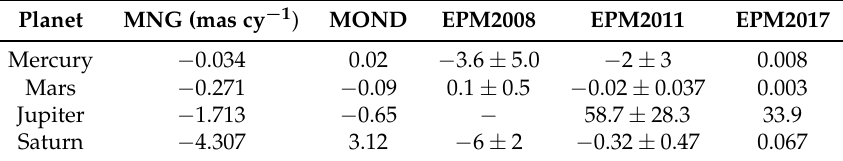
Table 2. The predictions of MOND—using the standard MOND function µ ( y ) = y / given [99]. Table 2. Prediction of the MNG model and MOND for the extra anomalous advance of the perihelion of the planets in comparison with the observations in the EPM2008 and EPM2011 ephemerides. In the case of EPM2017 only the formal uncertainties are given as deduced by Iorio